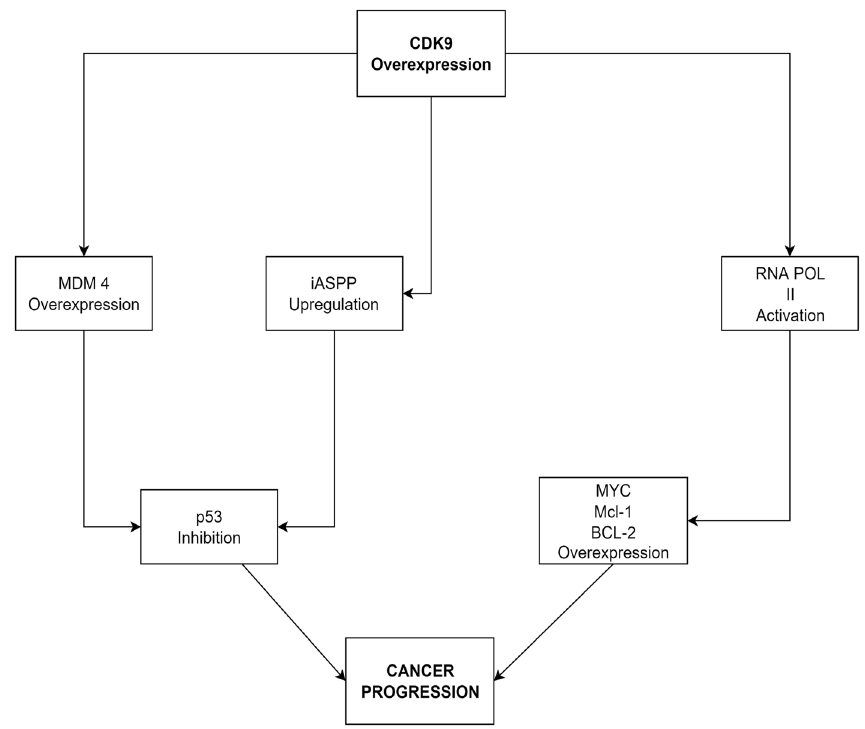
Figure 5. The role of CDK9 overexpression in cancer progression. CDK9 activates the mouse double minute 4 (MDM4) and the inhibitor of apoptosis-stimulating protein of p53 (iASPP) proteins, which inhibit the tumor-suppressing functions of p53 and disturb genomic integrity. Overexpression of CDK9 increases the activity of RNA polymerase II and causes an increase in anti-apoptotic proteins, such as c-Myc, Mcl-1, and Bcl-2, preventing the programmed death of cancer cells. Both pathways lead to the accumulation of genetic changes and the progression of the disease [12,13,30].